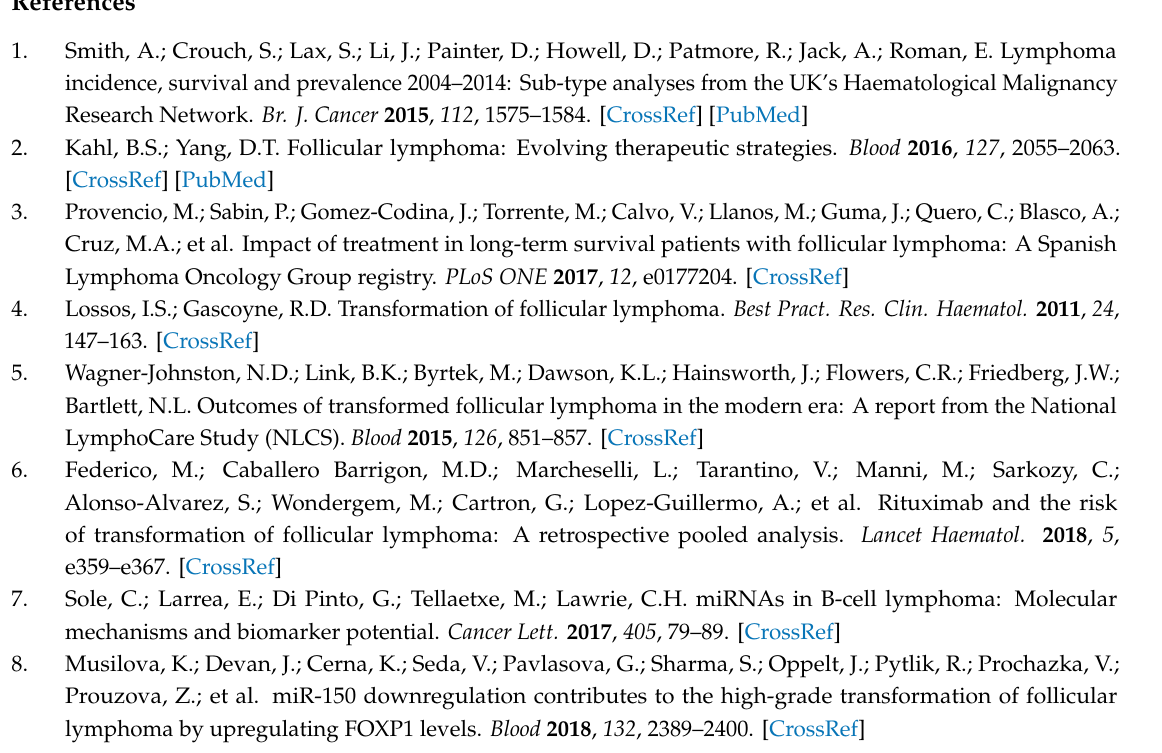
Figure S1: Distribution of the frequency of the mutations ( n = 2056) identified using WGS in 6 FL cases in protein coding genes; Figure S2. B-cell receptor signalling pathway; Figure S3: Sequencing coverage archived using the custom targeted sequencing panel; Figure S4. Schematic diagram of the construct for luciferase assays in psiCHECK-2 vector; Table S1. Mutations identified in predicted miRNA-binding sites in the WGS datatitle; Table S2. Recurrent mutations identified by targeted sequencing in the validation cohort and additional variants within predicted miRNA-binding sitestitle; Table S3. Sample detailed